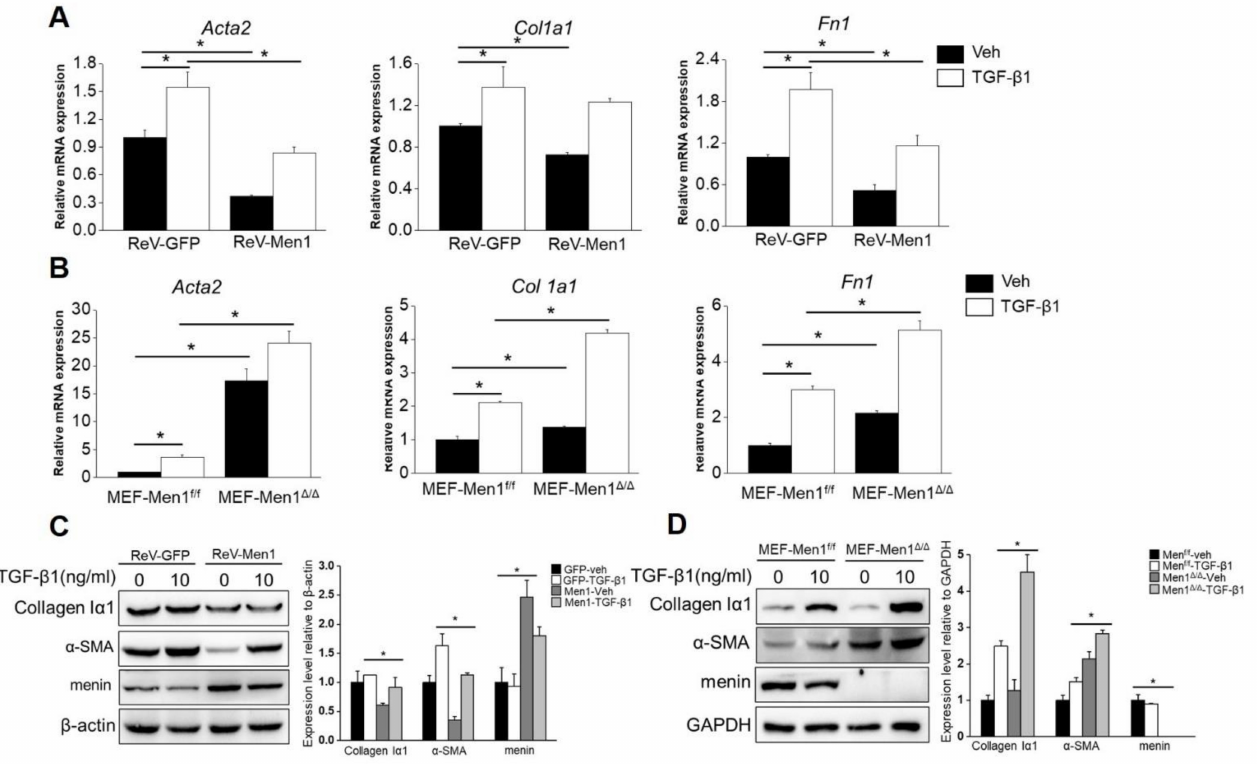
Figure 4. Men1 suppresses fibroblast activation and ECM protein expression. ( A ) MEFs were infected with retrovirus to overexpress Men1 and then exposed to recombinant TGF- β 1; the expression of Acta2, Col 1a1, and Fn1 were analyzed by qRT-PCR. ( B ) Men1-knockout MEFs and the control cells were treated with recombinant TGF- β 1, and qRT-PCR was used to determine the expressions of Acta2, Col 1a1, and Fn1. Data in ( A , B ) are from three repeated experiments. ( C , D ) Men1 overexpressing or knockout MEFs were stimulated with recombinant TGF- β 1. The expression of ECM proteins was determined by Western blotting, blots from two repeated experiments were quantified by Image J software. * p <